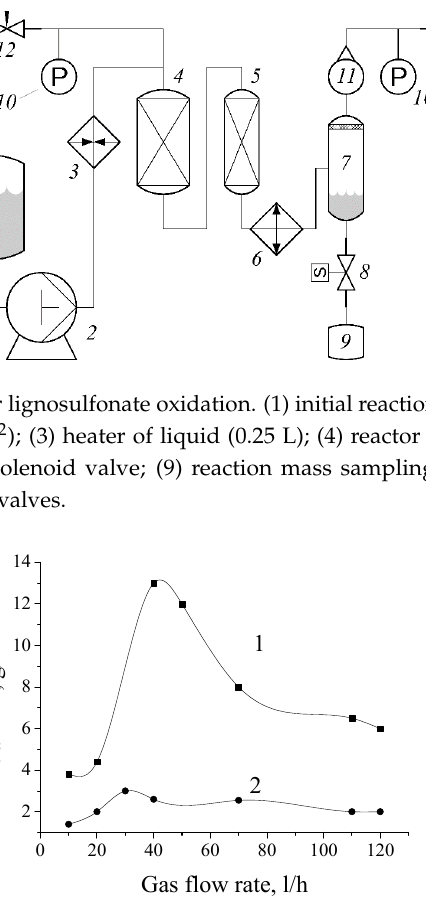
Figure 4. The influence of oxygen flow rate on yield of vanillin (1) and syringaldehyde (2) in oxidation of sulfite liquor in the flow reactor system. 170 °C, 0.9 MPa, 210 g/L of sulfite liquor dry mass, 150 g/L of NaOH, liquid flow rate 1.8 L/h (see reference [110]).